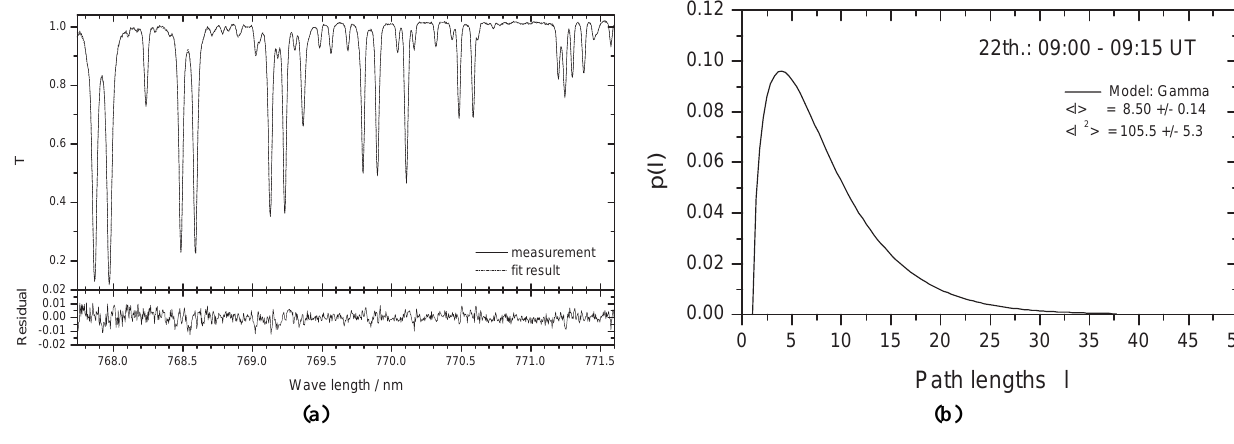
Fig. 3. (a) A sample for a measured and fitted spectrum with a typical residual. The oxygen spectrum consists of pairs of rotational lines. Also contained are strong Fraunhofer lines, e.g. at 768.2nm (Si I) and 770.1nm (K II). (b) The retrieved path length distribution corresponding to the spectrum above. A Gamma distribution is used as PDF model. 1 σ errors are included.